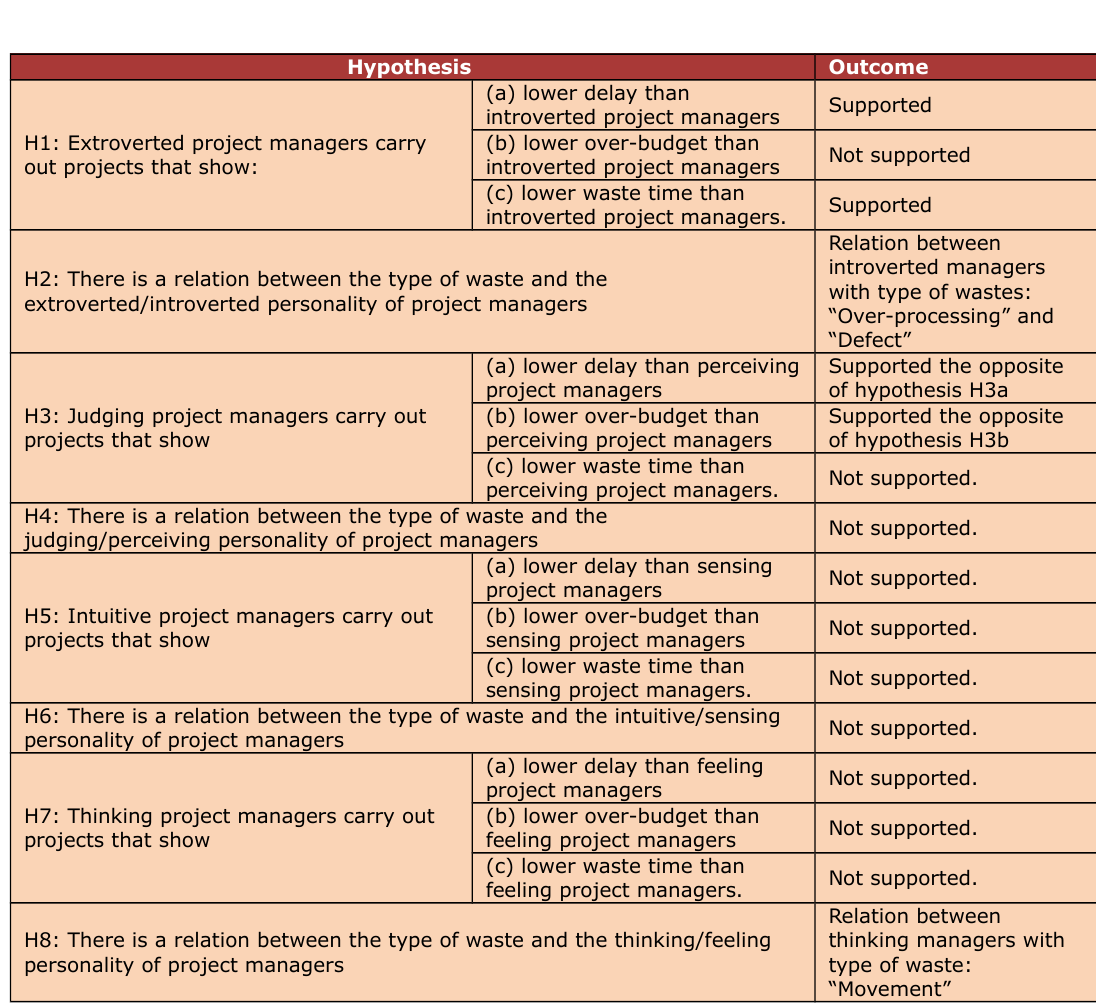
Table 12. Summary results of hypothesis